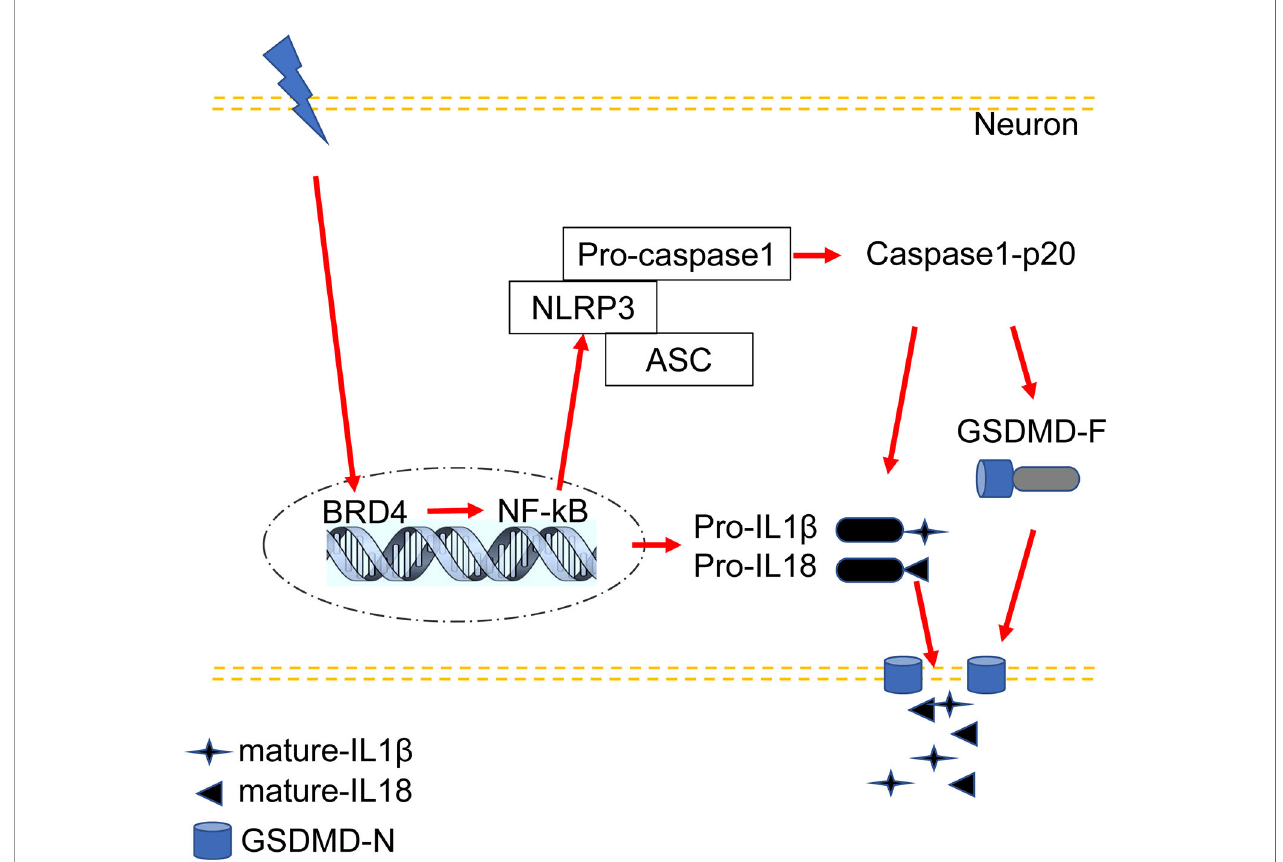
FIGURE 7 | Proposed mechanism: BRD4 regulates NLRP3 in fl ammasome-induced pyroptosis in CFA-induced in fl ammatory